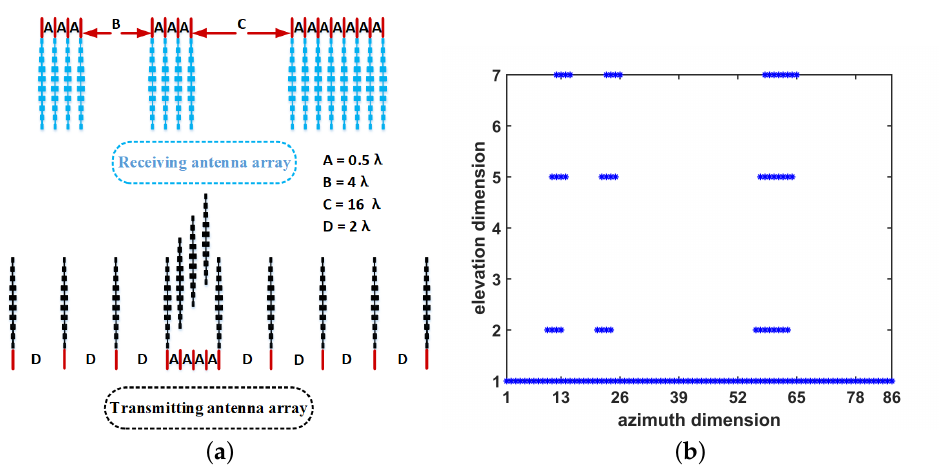
Figure 5. ( a ) Radar real antenna array. ( b ) Virtual antenna array.